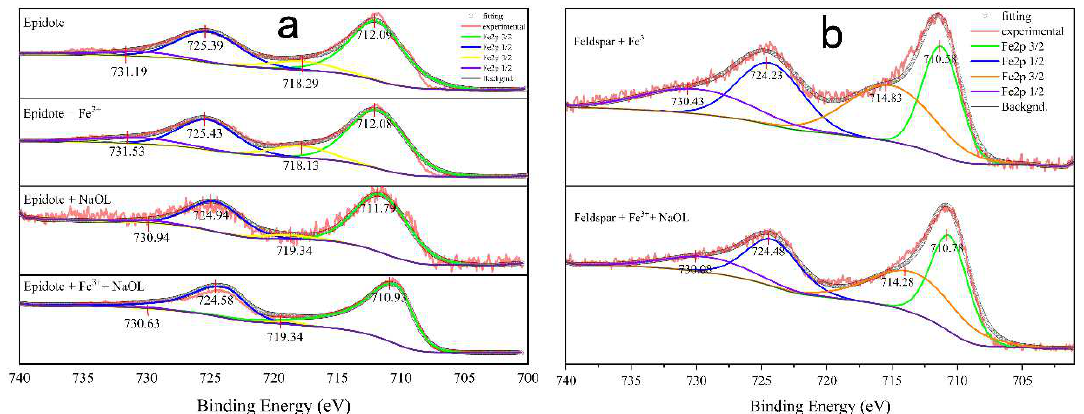
Figure 9. The XPS spectra of epidote.